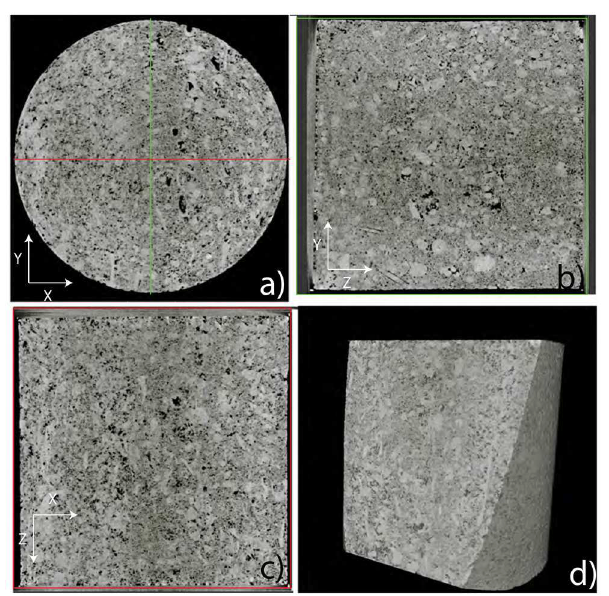
FIGURE 6 | X-ray tomography of the Indiana limestone sample IL3 (exp. 5). The sample is a cylinder with dimensions of 5 × 5 cm. (a) Slice in the middle of the sample, top view. (b) Slice in the middle of the sample, right side view. (c) Slice in the middle of the sample, front view. (d) 3D volume rendering. The pores in the sample are represented in black while fossil and sediment fragments are represented in bright or light gray. A darker gray domain, mostly in the center of the sample corresponds to lower density, fossil fragments are difficult to distinguish. They probably corresponds to fragments reduced into powder with consequently a higher inner porosity than the intact